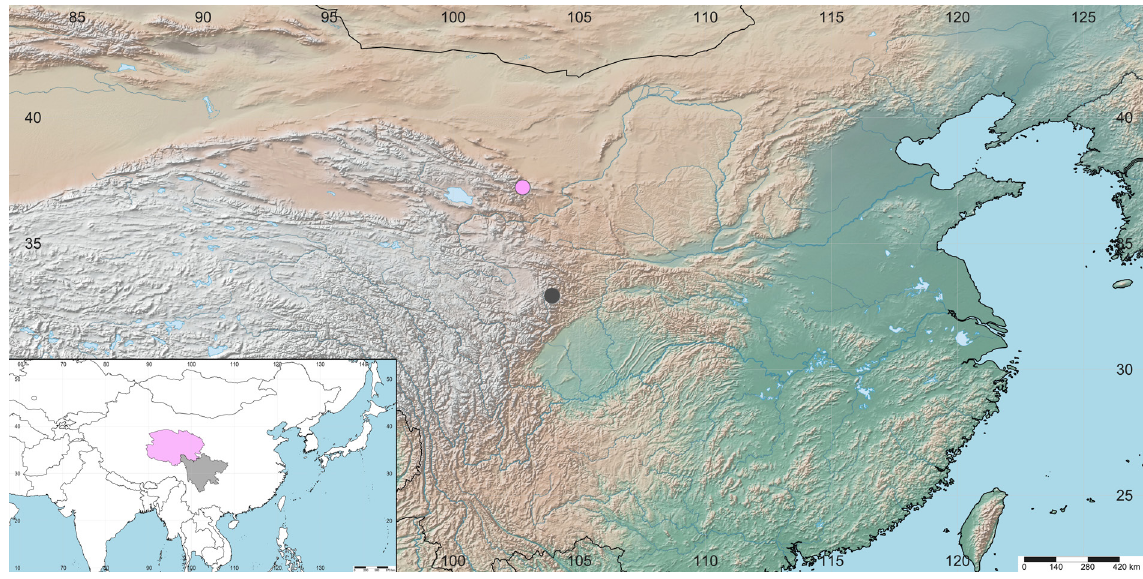
Fig. 1. Known distribution of genus Biema Huo & Zhao gen. nov. in China. Pink dot represents Biema qilianensis Huo & Liu gen. et sp. nov.; black dot represents Biema wanglangensis Huo & Zhao gen. et sp. nov.; pink area represents Sichuan Province, China; grey area represents Qinghai Province,